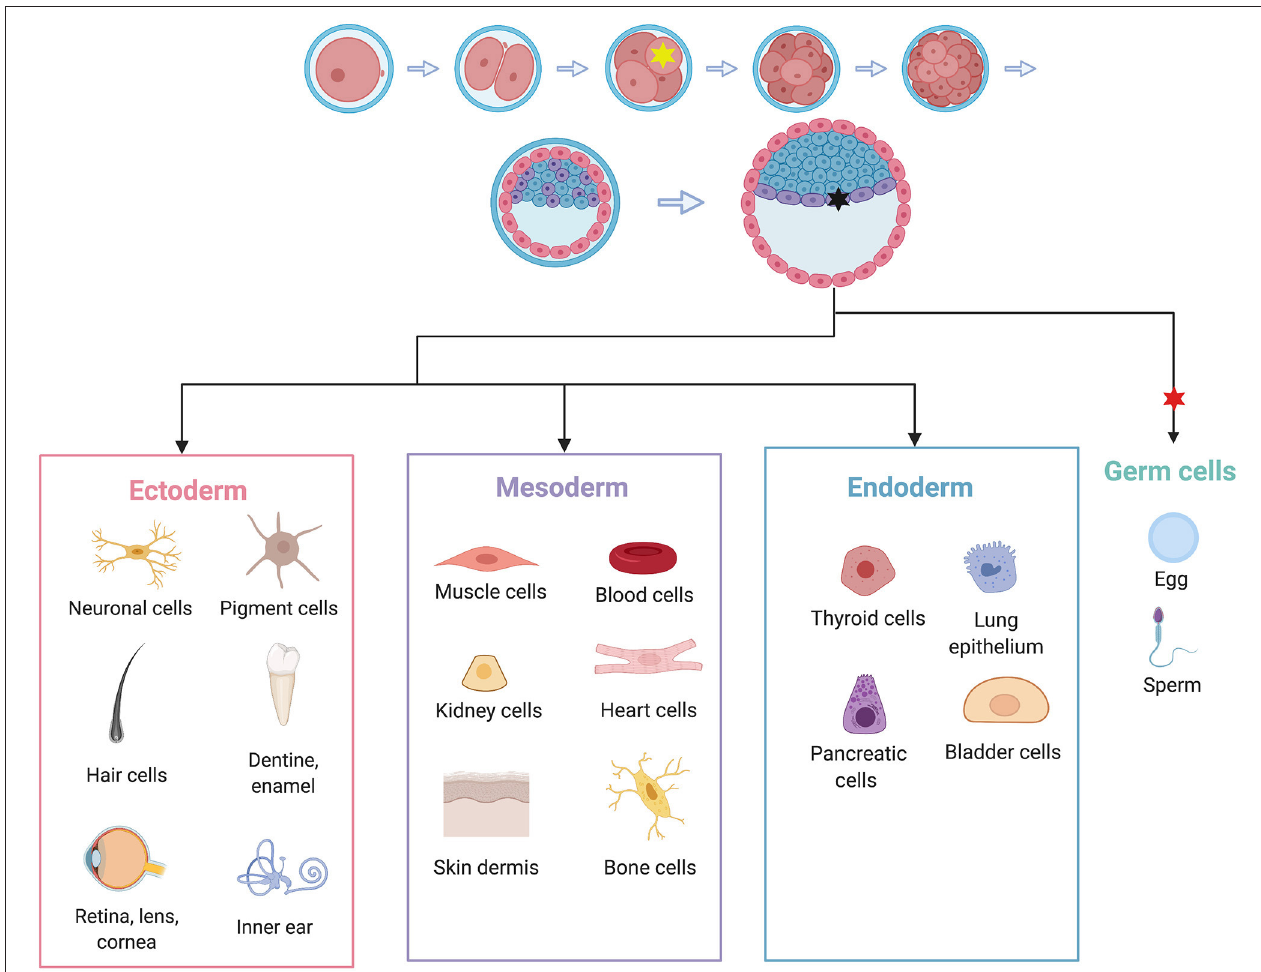
FIGURE 3 | Embryonic de novo mutations can result in highly variable phenotypes due to mosaicism. Individuals who acquire a mutation at the 4-cell stage, represented by the yellow star, may experience symptoms in all cell types (given that the variant in question has equal ability to affect all cell types). A variant acquired at the gastrula stage, represented by the black star, may only affect one germ layer and therefore a more restricted subset of cell types. In this example, the black mutation may only affect heart, muscle, kidney, skin, and bones, but not neuronal tissue. In the case of TS, this is a possible mechanism for cases that have symptoms restricted to LTQ and syndactyly. A variant that arises after germ cells have been set aside, represented by the red star, may only affect germ cells, and therefore may not cause phenotypes in the individual, but may affect the individual’s children. Adapted from “Human Embryonic Stem Cell Differentiation,” by BioRender.com (2020). Retrieved from: